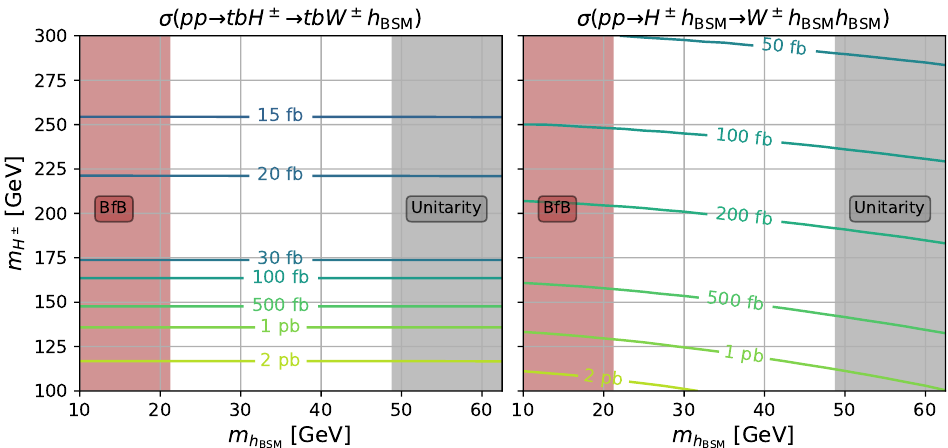
) parameter plane of benchmark scenario Figure 21. Signal cross sections in the ( m , m h H ± BSM cH ( Wh light ) . The contour lines indicate the 13 TeV LHC cross sections for the processes pp → BSM tbH ± , H ± → W ± h BSM ( left ) and pp → H ± h BSM → W ± h BSM h BSM ( right ). The shaded regions are excluded by perturbative unitarity and boundedness from below